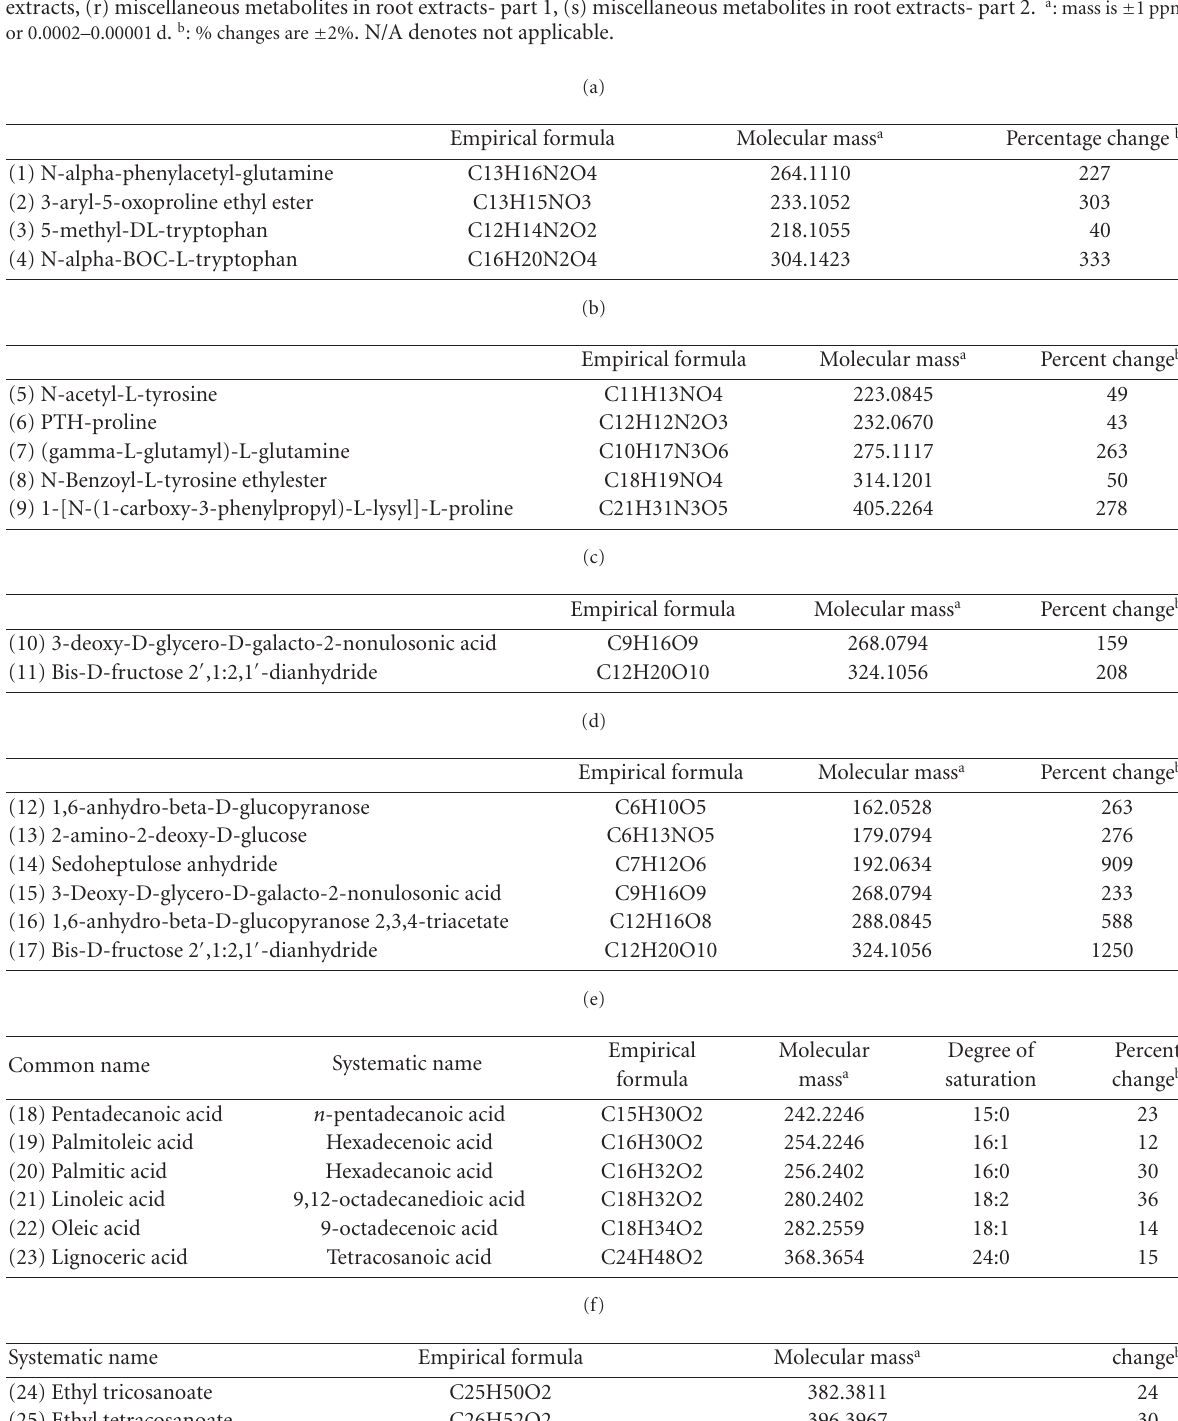
Table 5. Altered abundance (percentage change) in GDH plants compared to non-GDH plants in (a) amino acid derivatives in leaf extracts, (b) amino acid derivatives in root extracts, (c) sugars and derivatives in leaf extracts, (d) sugars and derivatives in root extracts, (e) fatty acids in leaf extracts, (f) fatty acid derivatives and conjugates in leaf extracts, (g) fatty acids in root extracts, (h) fatty acid derivatives and conjugates in root extracts, (i) compounds of special nitrogen metabolism in leaf extracts, (j) compounds of special nitrogen metabolism in root extracts, (k) nucleic acids in leaf extracts, (l) nucleic acids in root extracts, (m) TCA cycle intermediates and derivatives in leaf extracts, (n) TCA cycle intermediates and derivatives in root extracts, (o) metabolites involved in stress tolerance in leaf extracts, (p) metabolites involved in stress tolerance in root extracts, (q) miscellaneous metabolites in leaf extracts, (r) miscellaneous metabolites in root extracts- part 1, (s) miscellaneous metabolites in root extracts- part 2. a : mass is ±